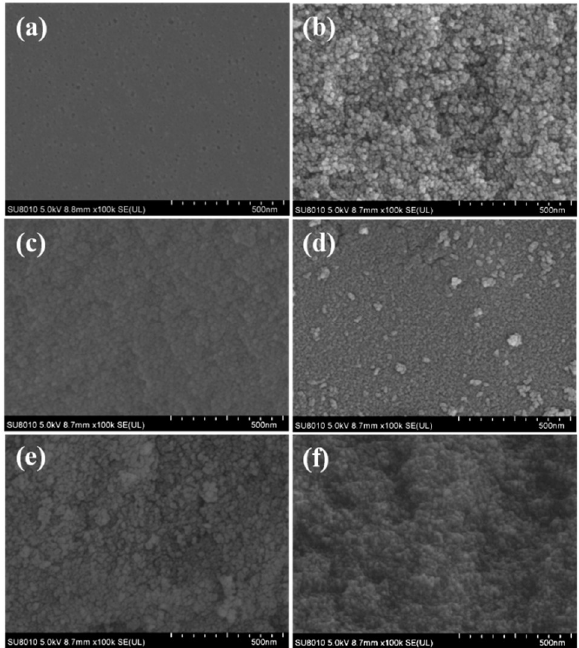
Figure 4. The surface SEM images of membranes with different NGRT@AC content ( a ) M 0 , ( b ) M 1 , ( c ) M 2 , ( d ) M 3 , ( e ) M 4 , ( f ) M 5 .